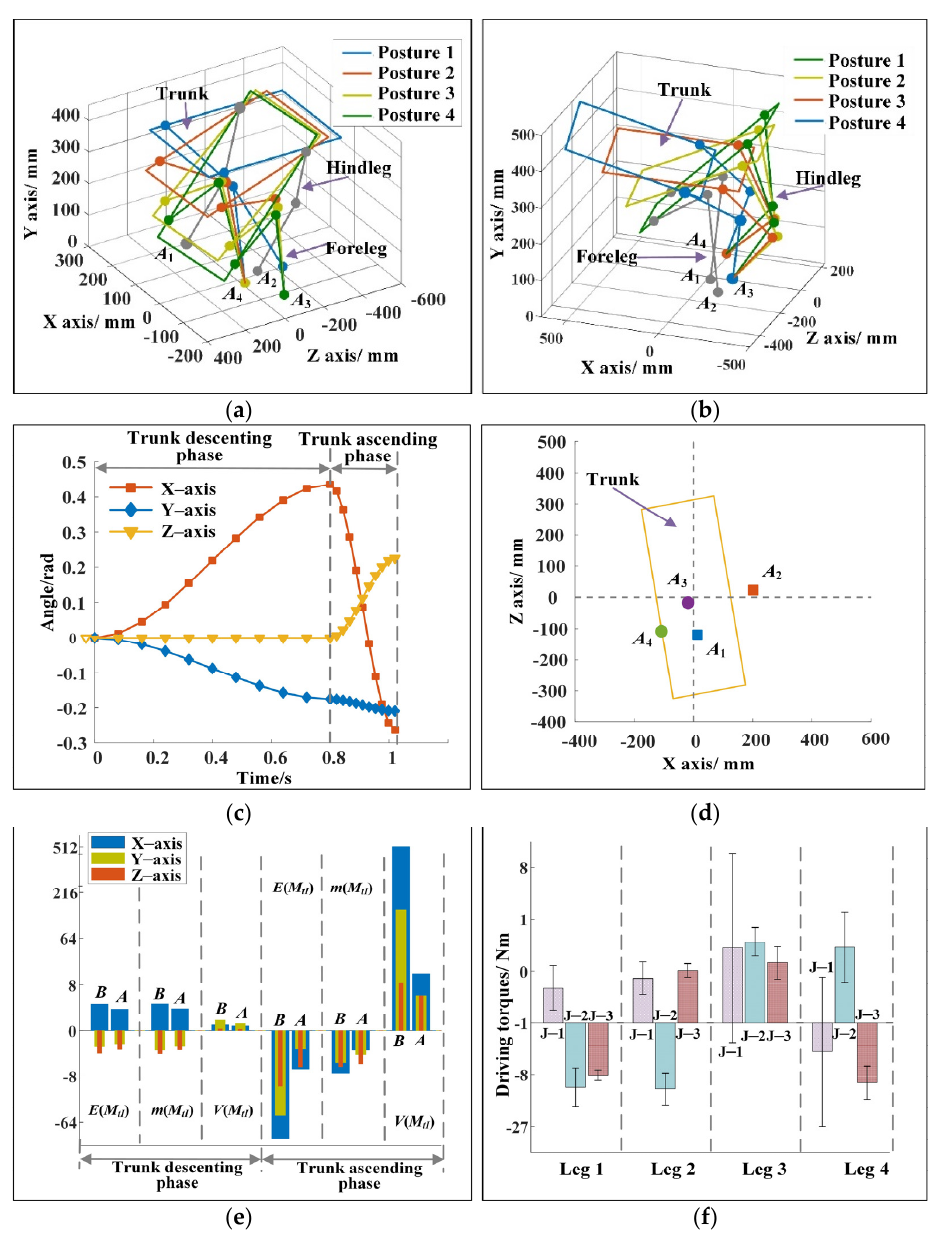
Figure 5. ( a ) Motion sequence of the robot in the descending phase of the trunk for example 2. ( b ) Motion sequence of the robot in the ascending phase of the trunk for example 2. ( c ) Changes of trunk posture for example 2. In the descending phase of the trunk, the angle changes of the trunk around the three axes are 25 ◦ , − 10 ◦ , and 0 ◦ . In the ascending phase of the trunk, the angle changes of the trunk around the three axes are − 40.01 ◦ , − 12 ◦ , and 12.88 ◦ . ( d ) The landing points of the forelegs and hindlegs for example 2. ( e ) Changes of the total inertia moment of the robot before and after optimization for example 2. The maximum reductions of the end value, the mean, and the variance of the total inertia moment of the robot after optimization are 98.9%, 90.2%, and 97.6%, respectively, and the decreases are evident. ( f ) Mean and variance of the driving torques for example 2. The maximum difference of the mean value is 5.88 N · m, and the maximum variance is 6.12 N · m. The driving torques are within reasonable